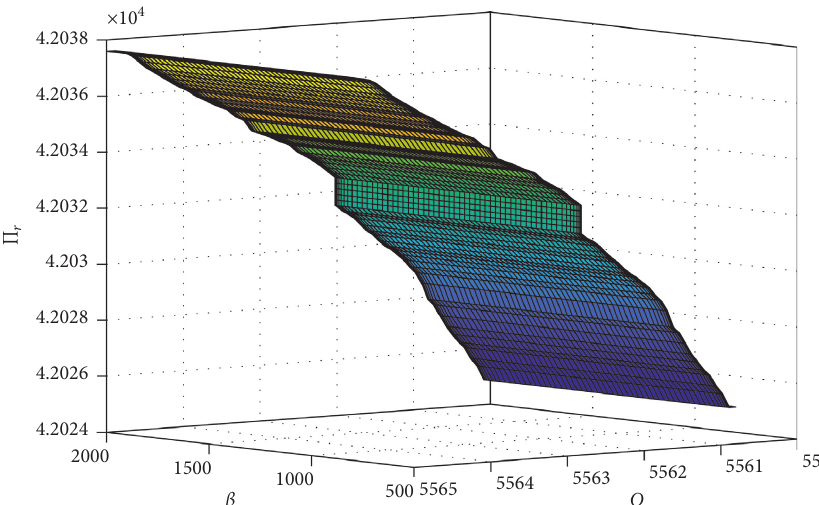
Figure 8: The impact of carbon emission reduction cost factors and order quantities on retailer revenue under decentralized decision-